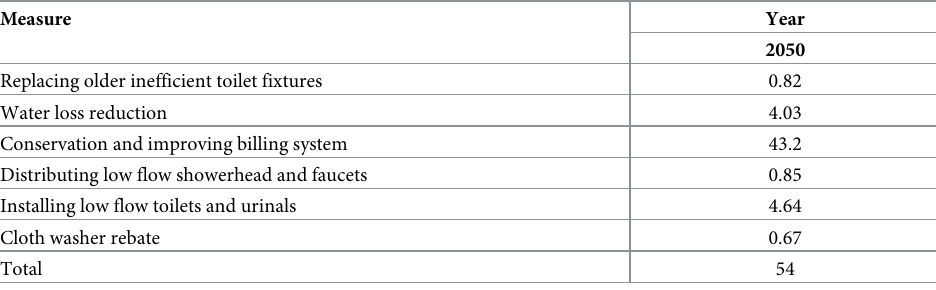
Table 11. Percent (%) of water saving by WCDM measures.